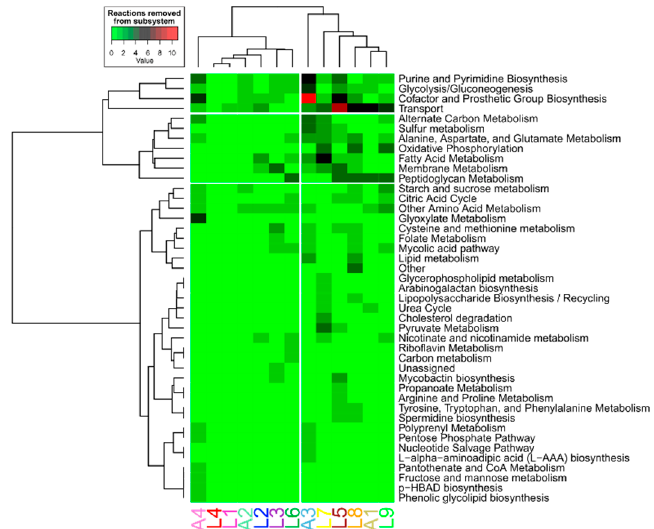
Figure 5. Hierarchical clustering analysis of the number of reactions removed of each subsystem within each lineage. Each row represents the number of reactions within each subsystem that were shut down when the genes were removed from the models, whereas the columns are the lineage- specific models. The clustering was performed with Euclidean and Ward D aggregation method.